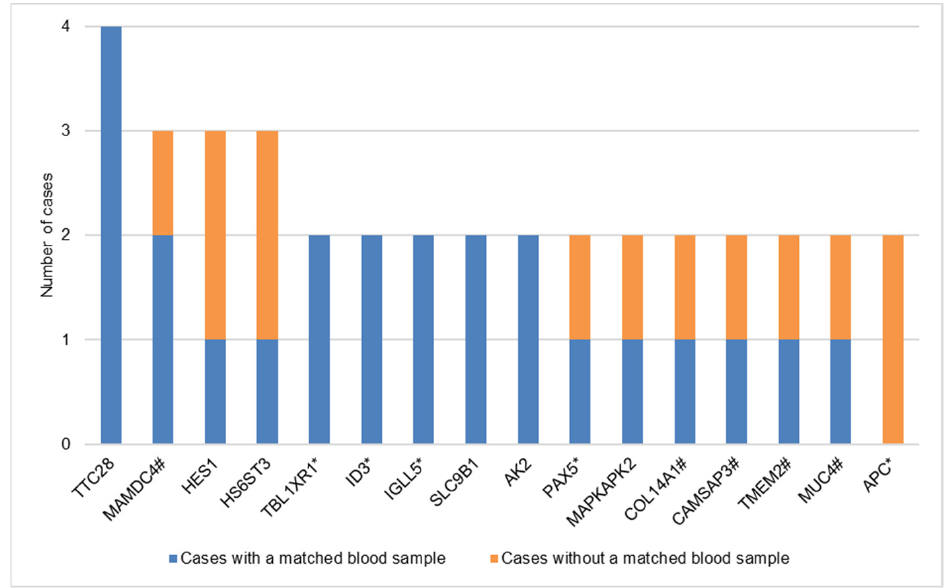
Figure 2. Recurrently mutated (>1 case) genes among 17 cases with primary Sjogren’s syndrome related extranodal marginal zone lymphoma of mucosa-associated lymphoid tissue. The vertical axis represents the number of cases. The horizontal axis represents the recurrently mutated genes.